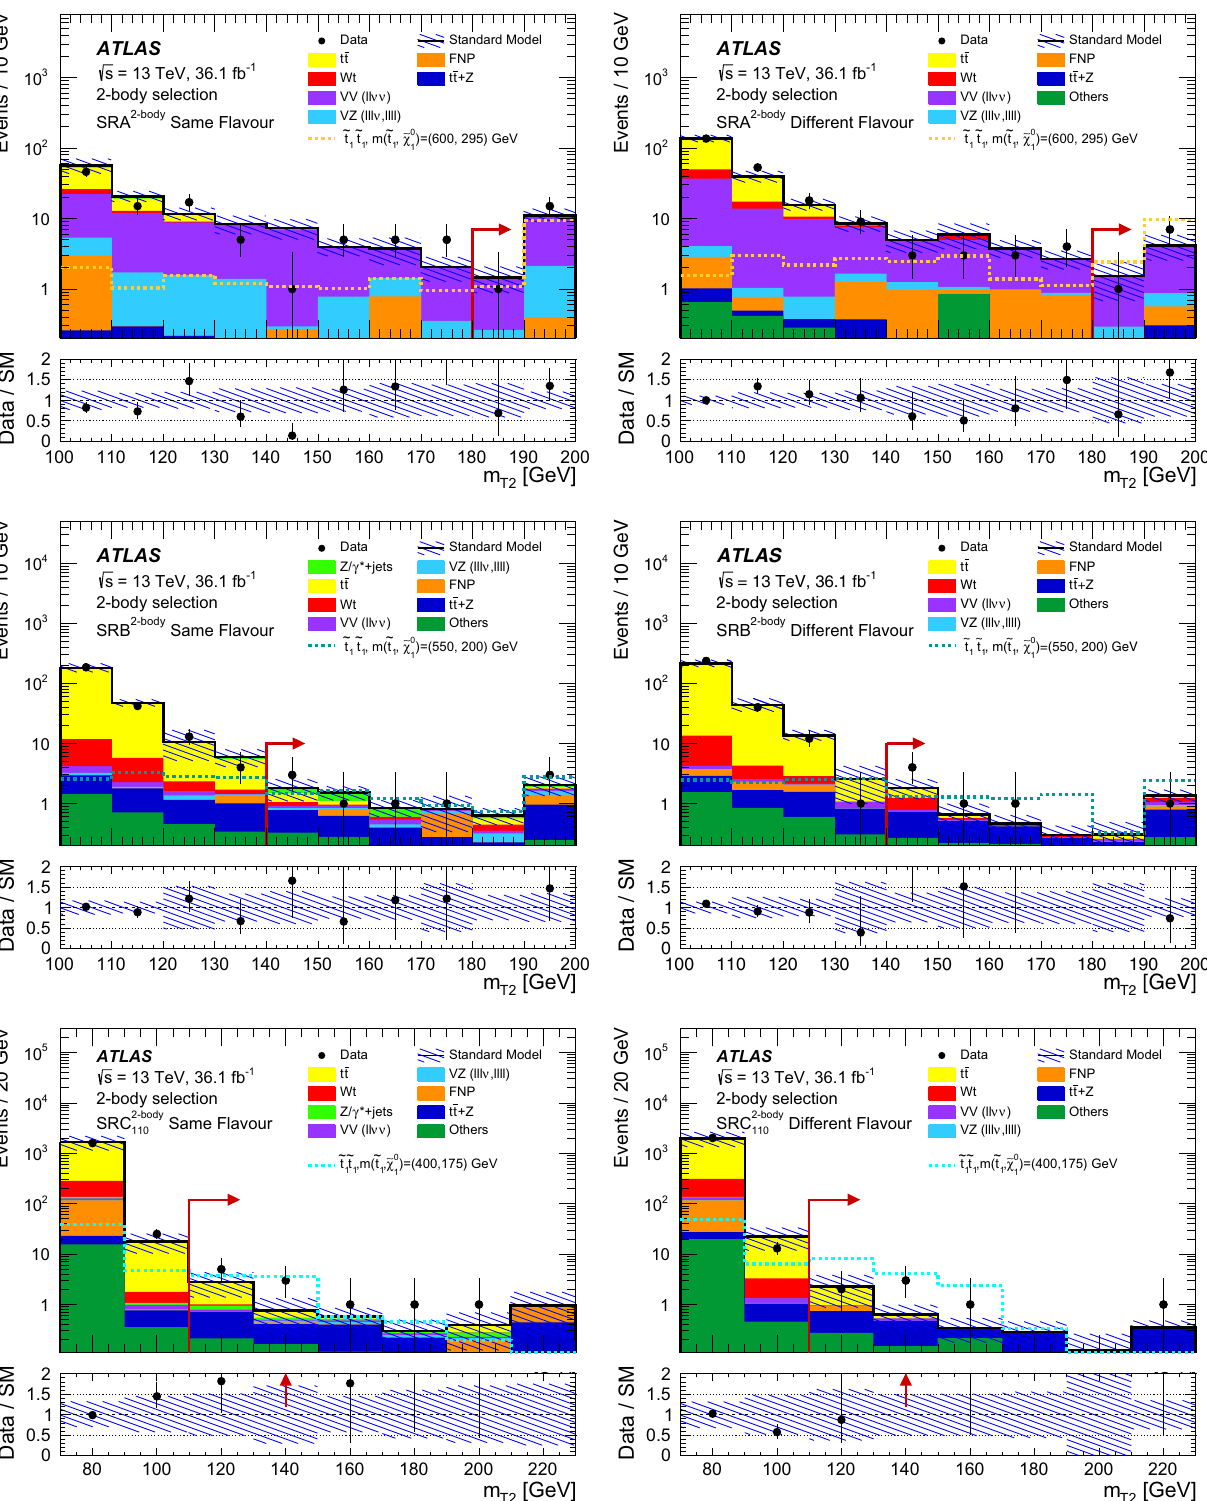
(cid:3)(cid:3) been performed. The counting uncertainty on data is also shown by for events satisfying T2 (cid:3)(cid:3) the black error bars. The rightmost bin of each plot includes overflow , after T2 events. Reference top squark pair production signal models are over- layed for comparison. Red arrows indicate the signal region